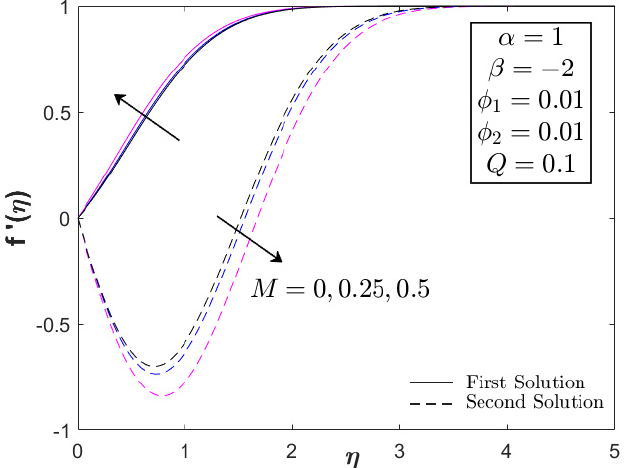
Figure 10. Velocity profile of Fe 3 O 4 –CoFe 2 O 4 /H 2 O with different M .